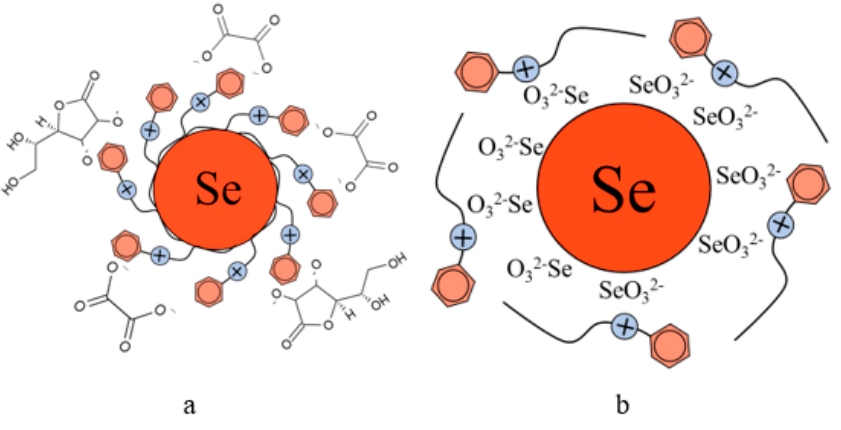
Figure 7. Diagrams of the structure of micelles in samples of Se NPs stabilized with catamine AB: negatively charged sample ( a ), and positively charged sample ( b ).